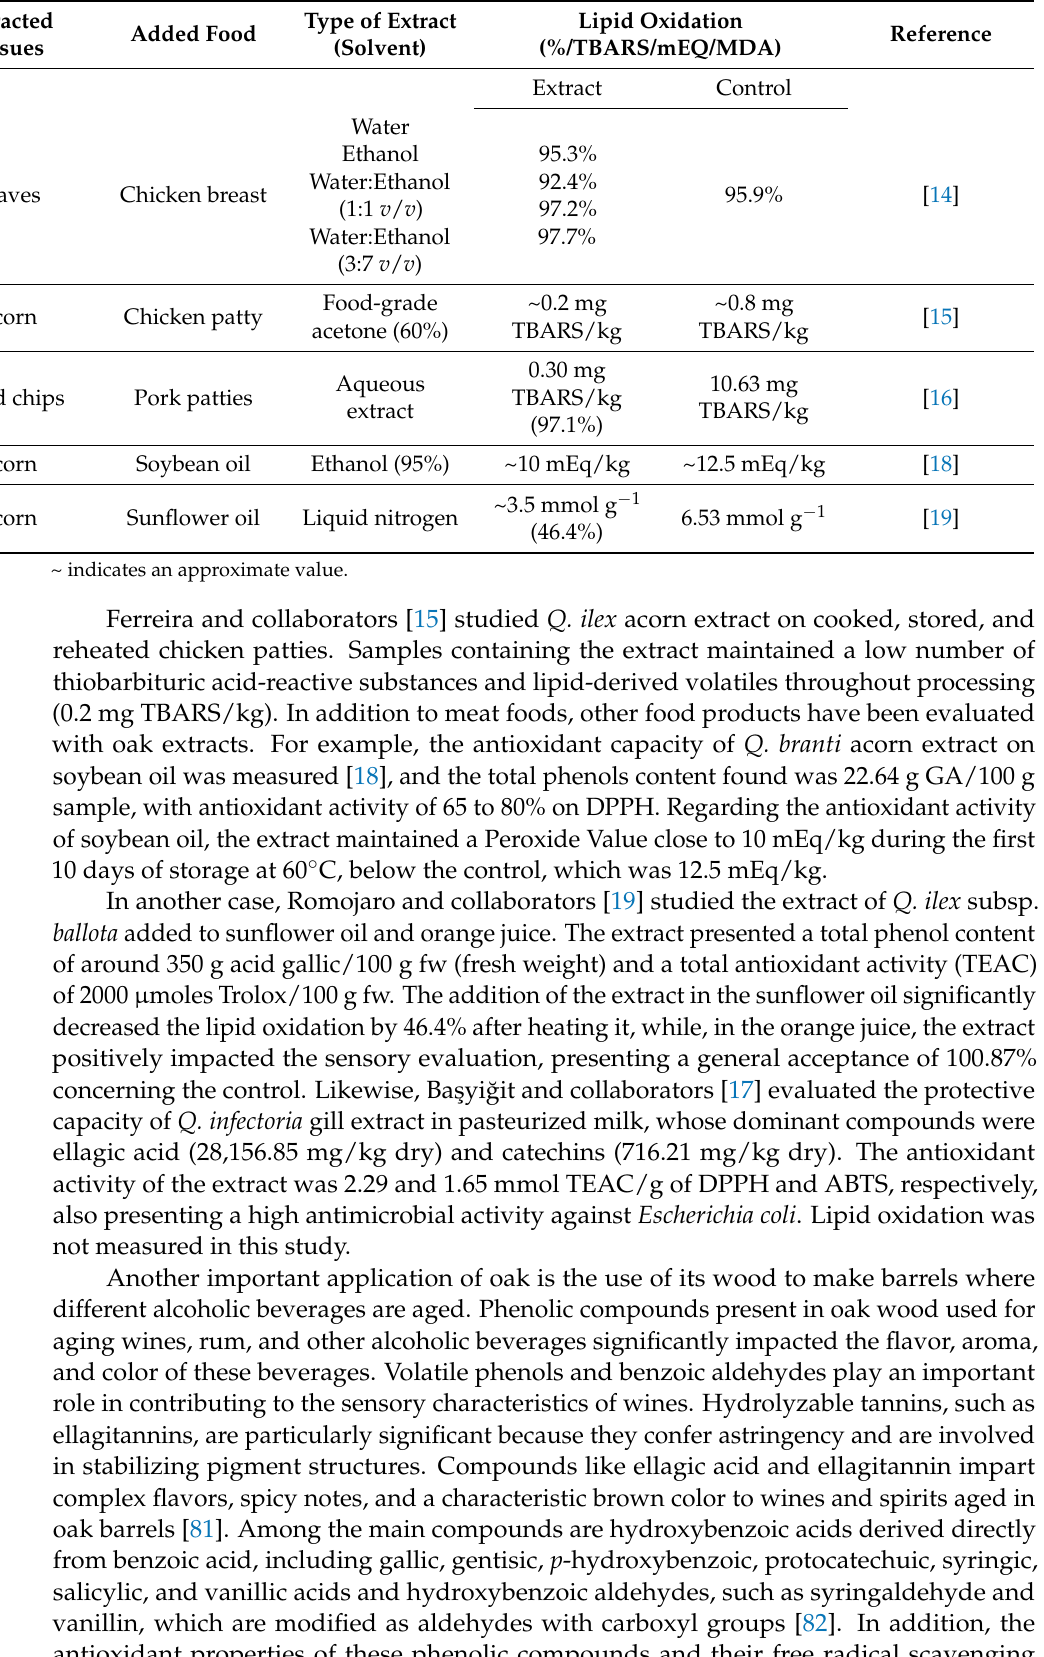
Table 3. Potential of oak extract to inhibit lipid oxidation (TBARS/Peroxide value) in different